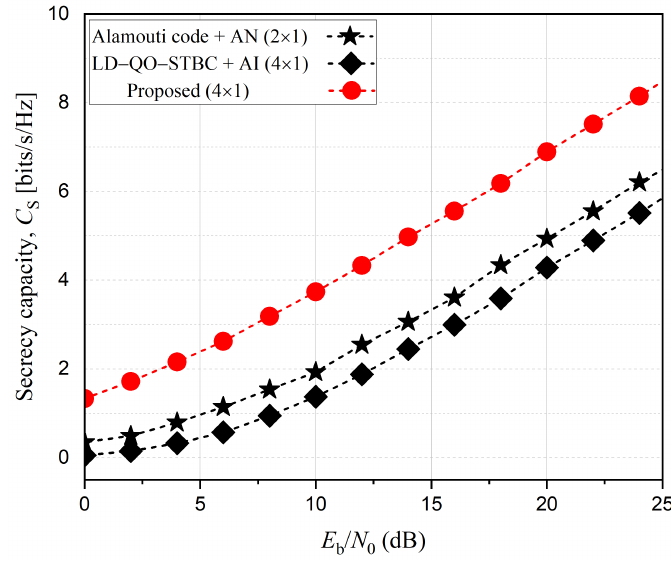
Figure 7. Secrecy capacity comparison of various PLS